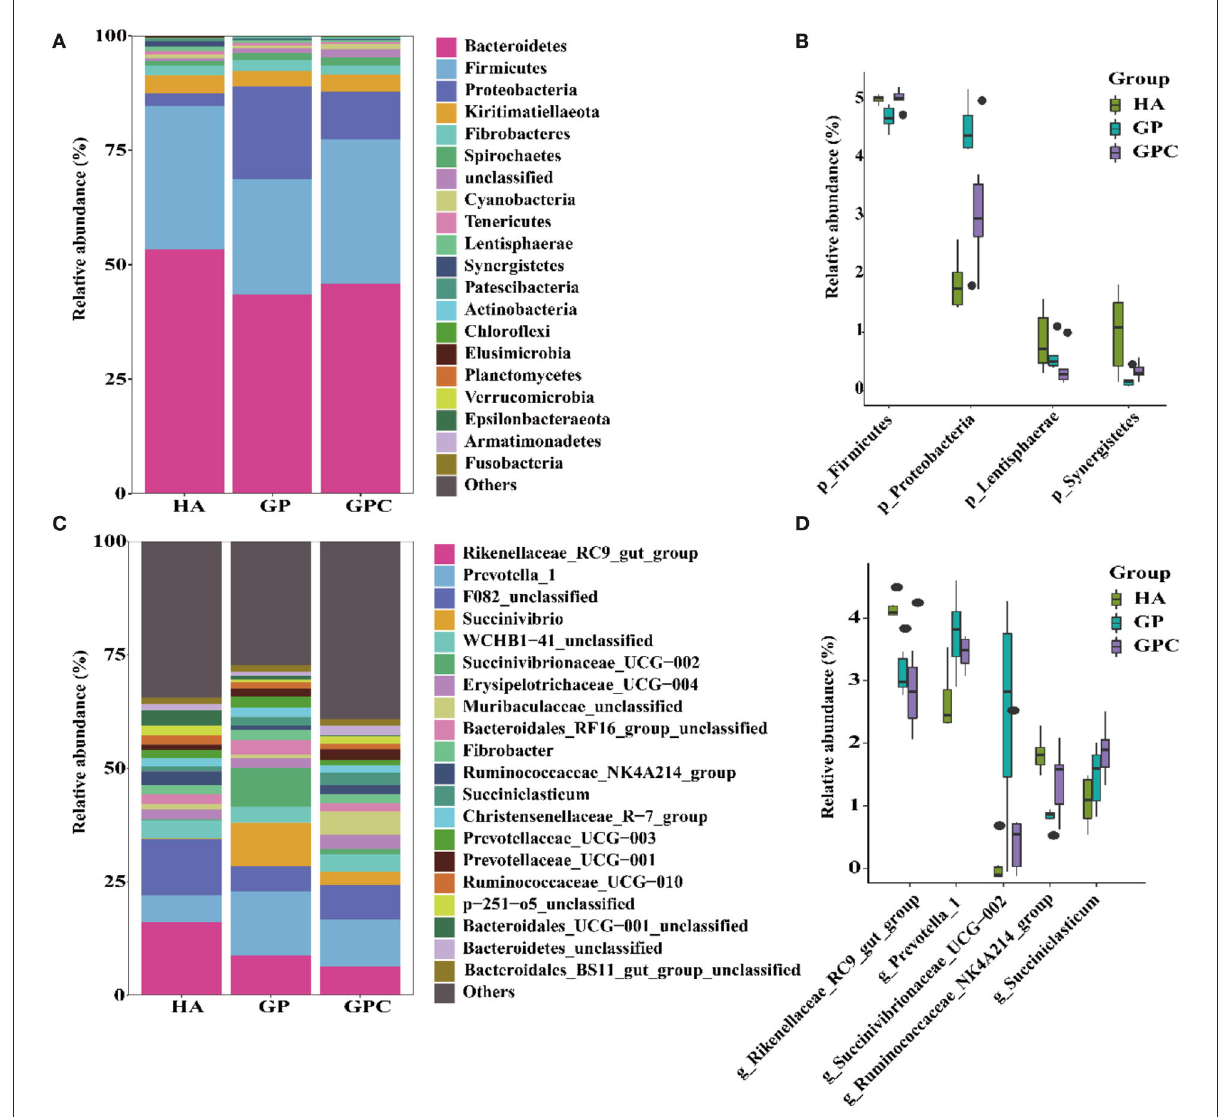
FIGURE3 The relative abundance (%) of bacterial phyla (1% at least in one group) of ruminal microbiome of lambs fed non-pelleted native grass hay without or with concentrate or pellets ( n = 6). (A) Phylum level. (B) Extended error bar plot showing the bacteria at the phylum level that had significant differences among the HA, GP, and GPC groups. (C) Genus level. (D) Extended error bar plot showing the bacteria at the genus level that had significant differences among the HA, GP, and GPC groups. HA, non-pelleted native grass hay diet, GP, pelleted native grass hay diet; GPC, pelleted native grass hay with concentrate